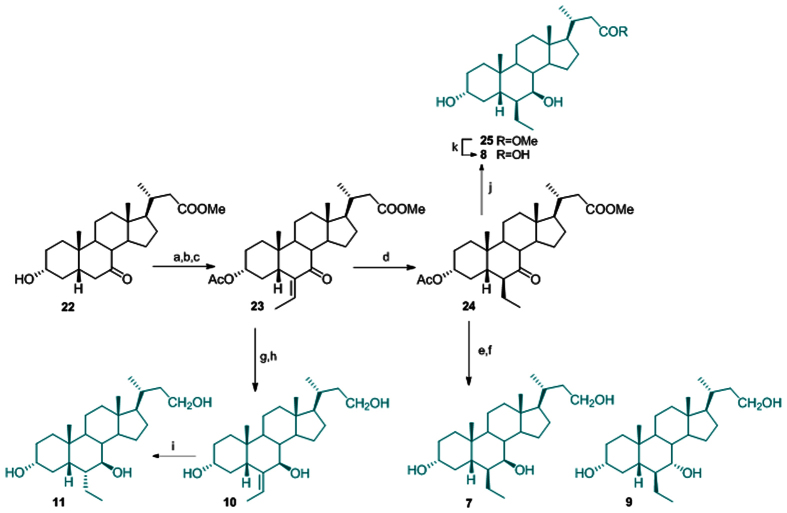
Synthesis of 3α-hydroxy-6-ethylnorcholane derivatives.Reagents and conditions: (a) acetic anhydride, pyridine; (b) DIPA, n-BuLi, TMSCl, TEA dry, THF dry −78 °C; (c) acetaldehyde, BF3(OEt)2, CH2Cl2, −60 °C, 60% over three steps; (d) H2, Pd(OH)2, THF/MeOH 1:1, quantitative yield; (e) NaBH4, MeOH dry, 0 °C; (f) LiBH4, MeOH, THF dry, 0 °C, 77% over two steps; (g) NaBH4, MeOH; (h) LiBH4, MeOH dry, THF, 0 °C, 85% over two steps; (i) H2, Pd(OH)2, THF:MeOH 1:1 v/v, quantitative yiel; (j) NaBH4, MeOH dry, 0 °C; (k) NaOH, MeOH:H2O 1:1 v/v, 82% over two steps.